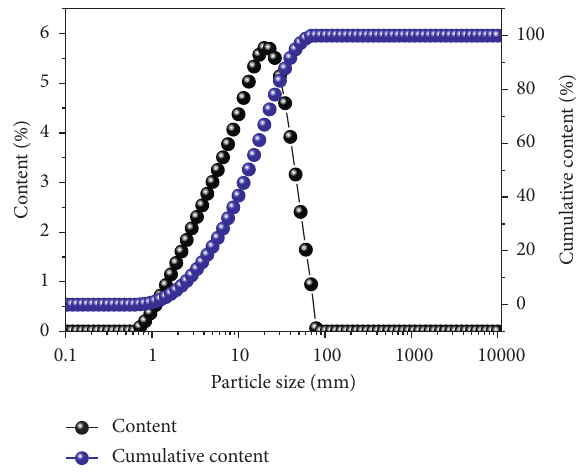
Figure 2: Particle size distribution of GGBFS.